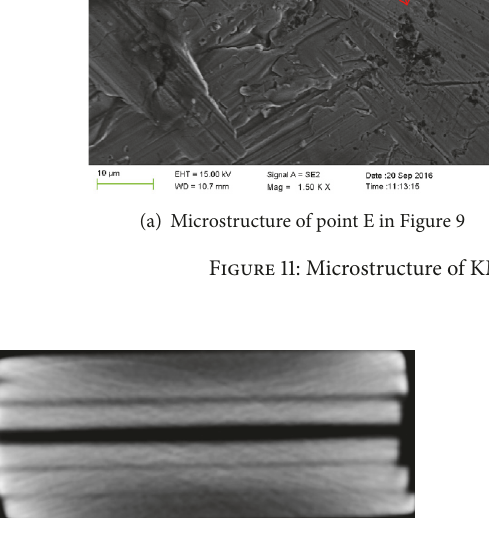
Figure 12: Tomography scanning of the KMN-I bending fatigue